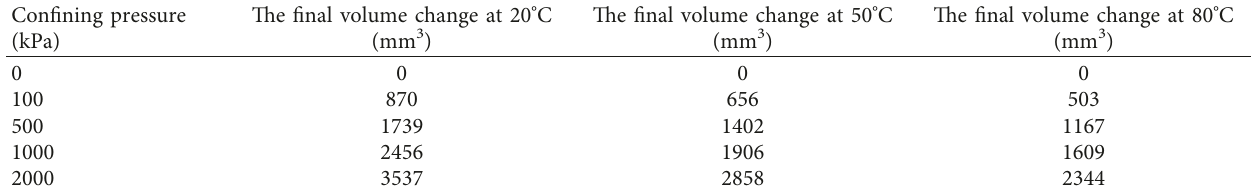
Table 1: The calibration results of the high-temperature and high-pressure triaxial